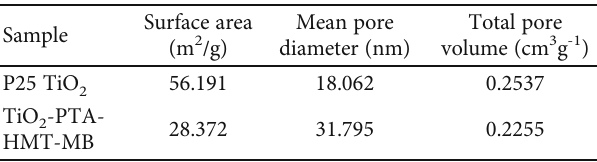
and TiO -PTA-HMT-MB for determining the band gap energy from variation of ( α h ν ) 2 2 2 adsorption-desorption isotherm, and (d) TGA and DSC curves of TiO 2 Table 1: Textural parameters of the P25 TiO HMT-MB